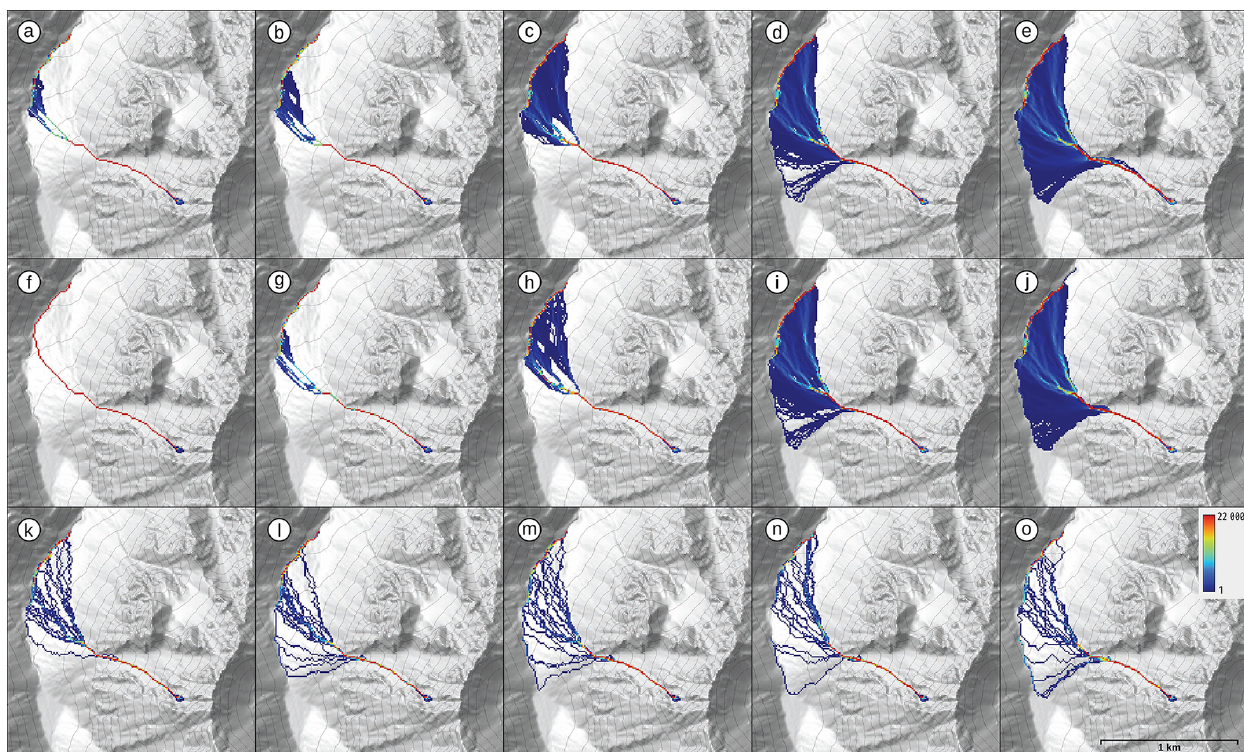
Figure 4. Effect of different random walk parameter settings; (a) – (e) different exponents for divergent flow (1.0, 1.1, 1.2, 1.5 and 2.0); (f) – (j) different slope thresholds (15 ◦ , 20 ◦ , 30 ◦ , 40 ◦ and 60 ◦ ); (k) – (o) different persistence factors (1.0, 1.5, 2.0, 2.5 and 3.0). For details see